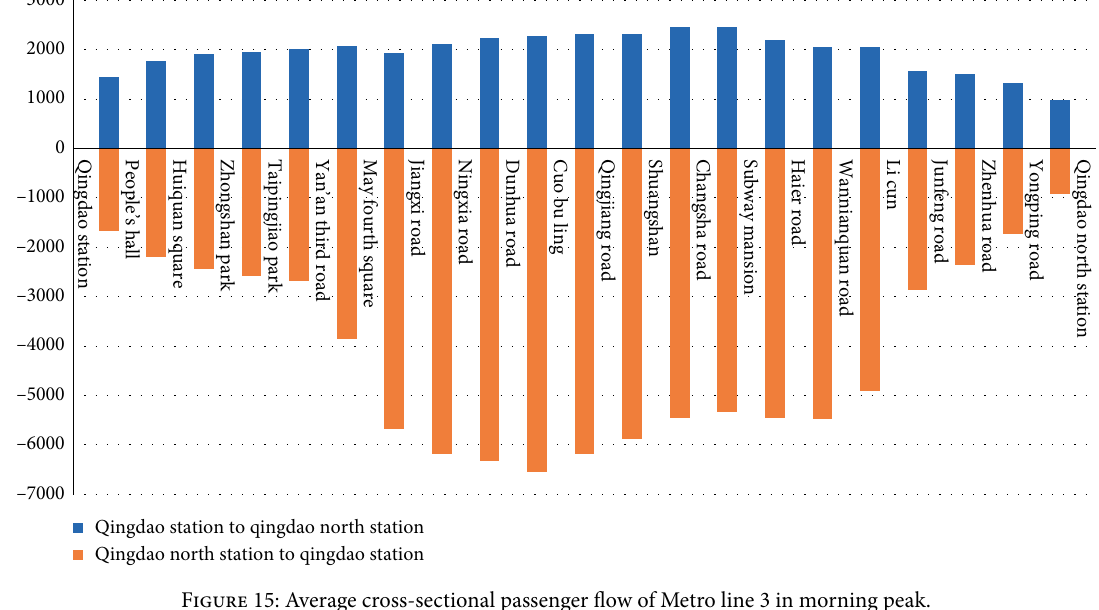
Figure 15: Average cross-sectional passenger flow of Metro line 3 in morning peak.